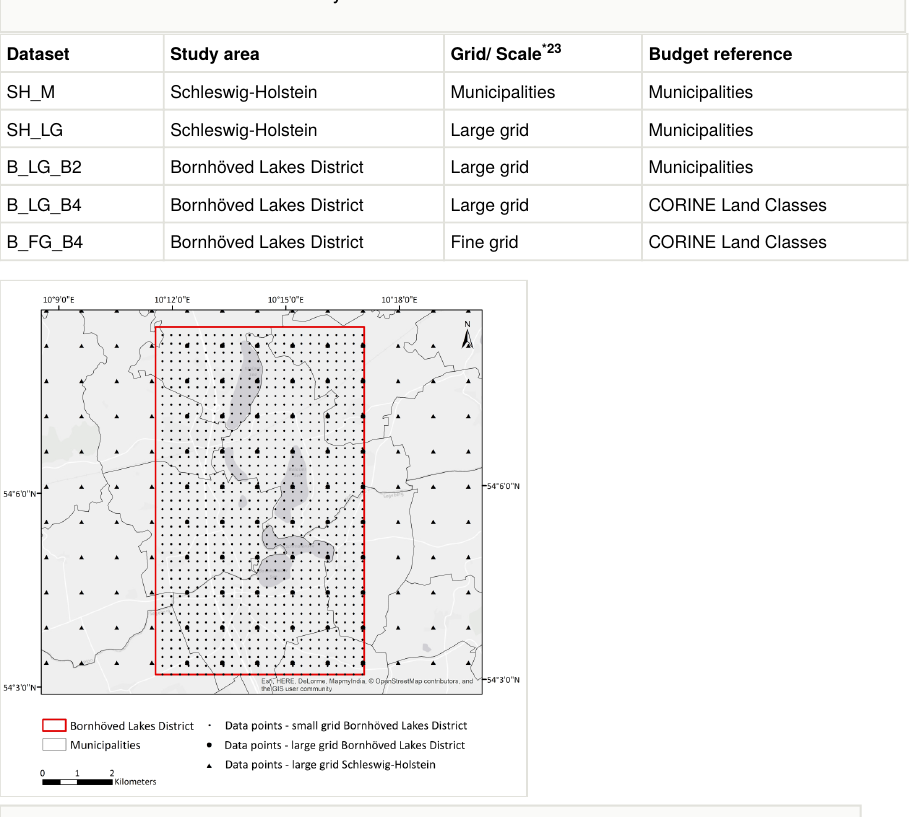
Datasets used for the statistical analysis.